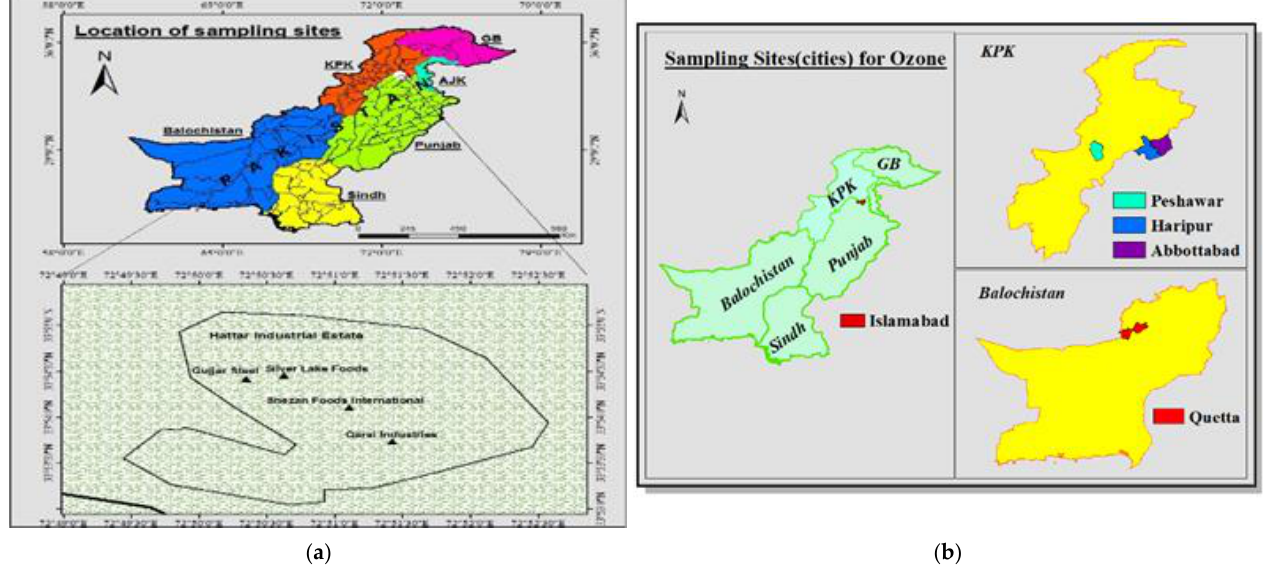
Figure 1. ( a ) indoor and ( b ) outdoor sampling points at industrial units